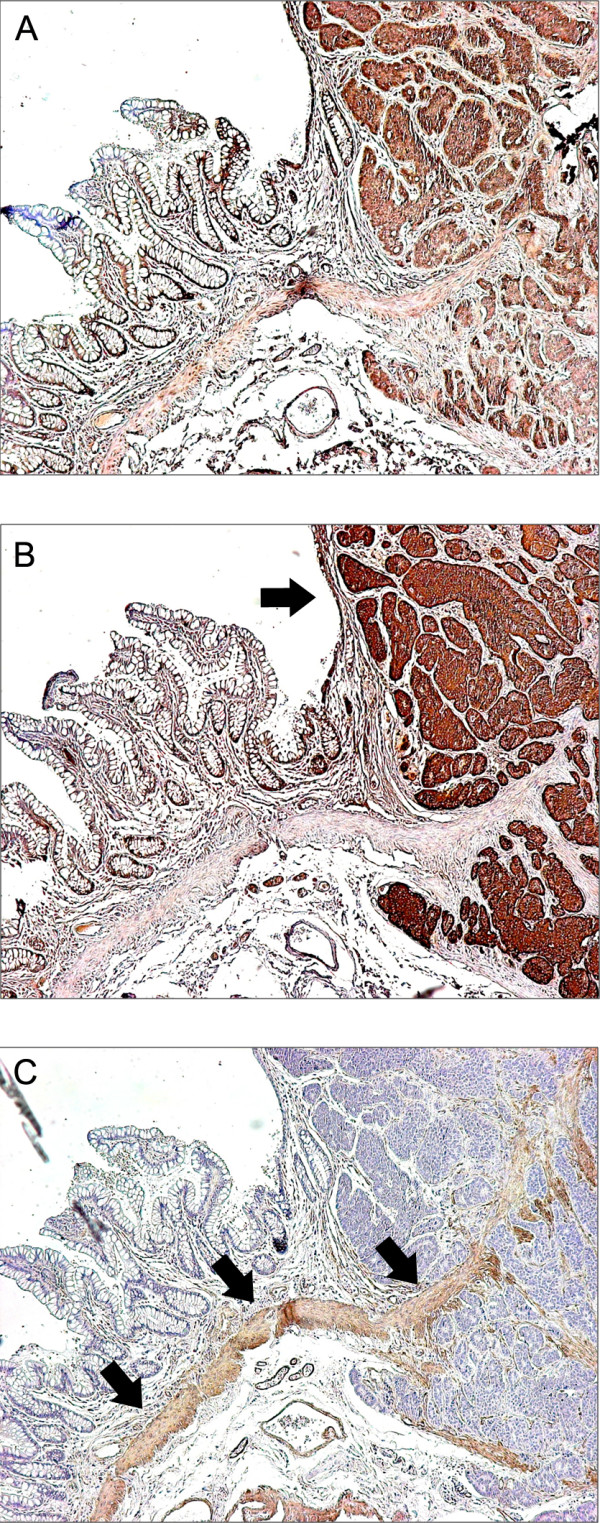
Immunostaining of neuroendocrine tumors. Representative photomicrographs demonstrating anti-connective tissue growth factor (CCN2) (panel A) immunostaining of gut carcinoid tumor tissue. CCN2 immunoreactivity was seen in cells corresponding to chromogranin A-positive tumor cells and gut smooth muscle (denoted by arrows in panels B and C, respectively). All sections were counterstained with hematoxylin. Magnification ×50.